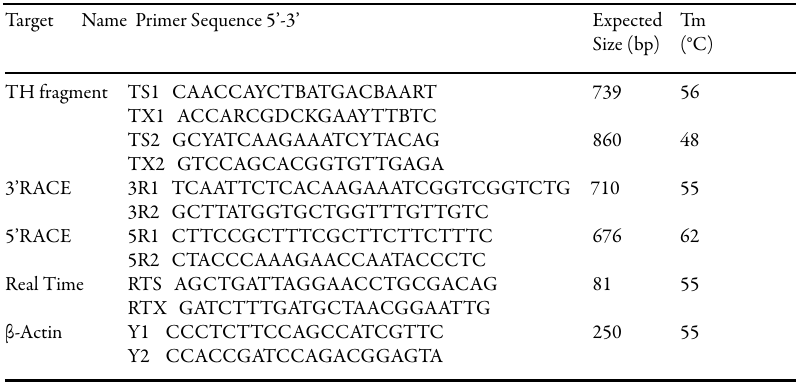
table 1. Oligonucleotide primers used for cDNA cloning and real-time quantitative reverse transcription-polymerase chain reaction